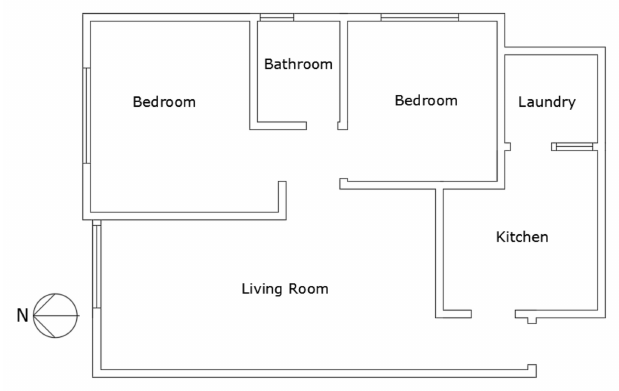
Figure 3. Floor plan of the house.